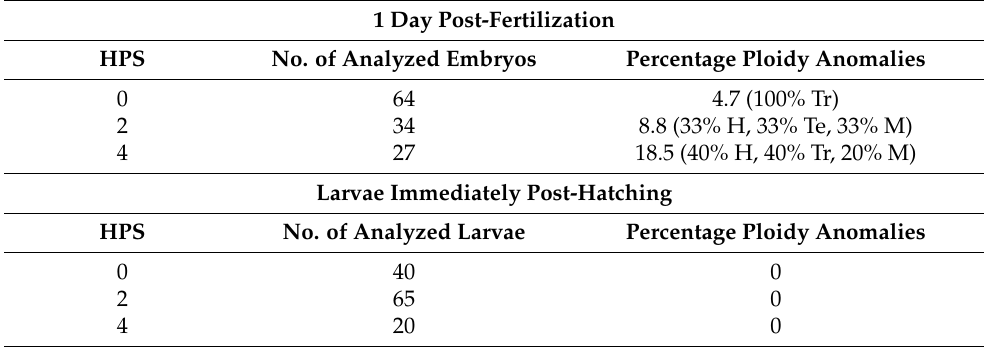
Table 1. Effect of post-ovulatory oocyte ageing on ploidy anomalies in the embryos (1-day old) and larvae (immediately post-hatching) of